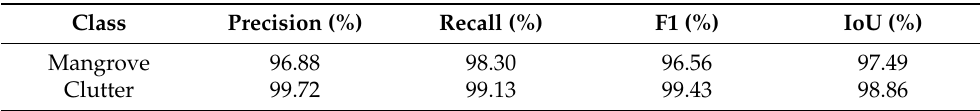
Table 3. The metrics of our best model, including precision, recall, F1 score and IoU value for mangrove extraction from remote sensing